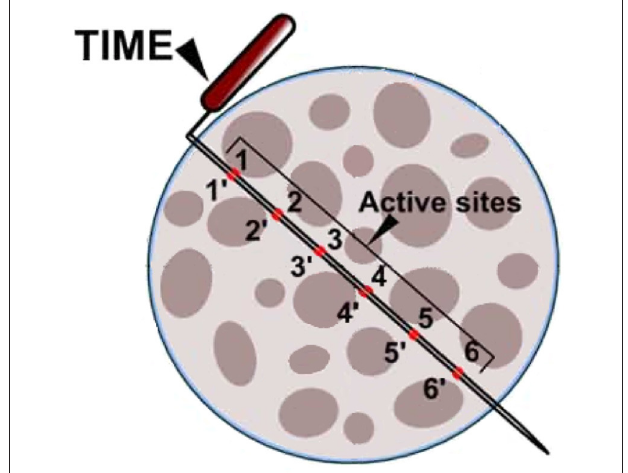
FIGURE 3 | Schematic drawing of a cross section of the median nerve (not to scale), with an implanted TIME electrode. TIME has six equidistant contacts on each side of the polyimide loop. Reproduced with permission from Kundu et al. (2014a).